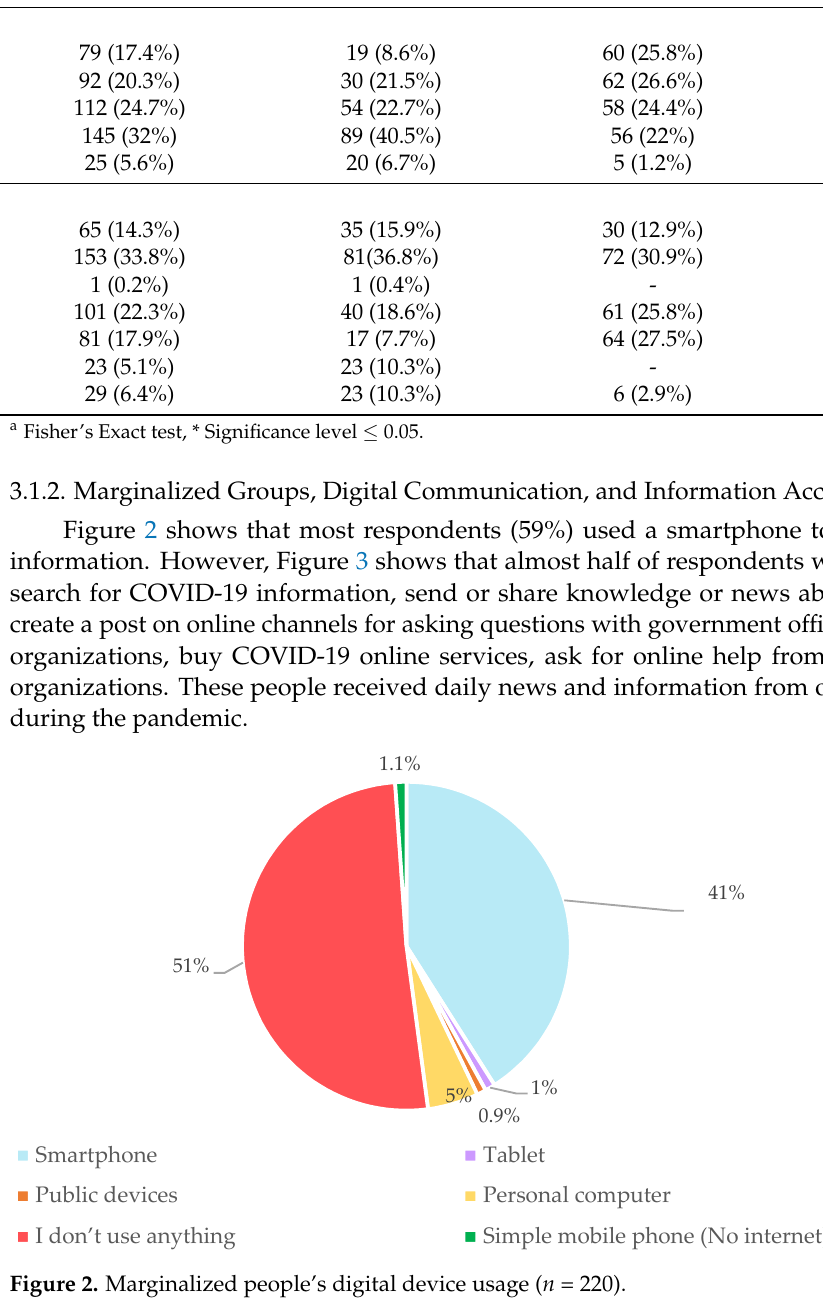
Figure 3. Marginalized people’s digital competence (n = 220). Figure 4 shows the percentage of people’s beliefs on the trustworthiness of COVID- 19 sources. Slum people believed in the information provided by the TV rather than other sources. They considered online COVID-19 information given by social media as not trustworthy because many of them believed that many organizations tried to create disinformation regarding COVID-19 cases. Thus, they chose to trust community leaders, local healthcare workers, and Duang Prateep Foundation staff (NGO) who work closely with them.